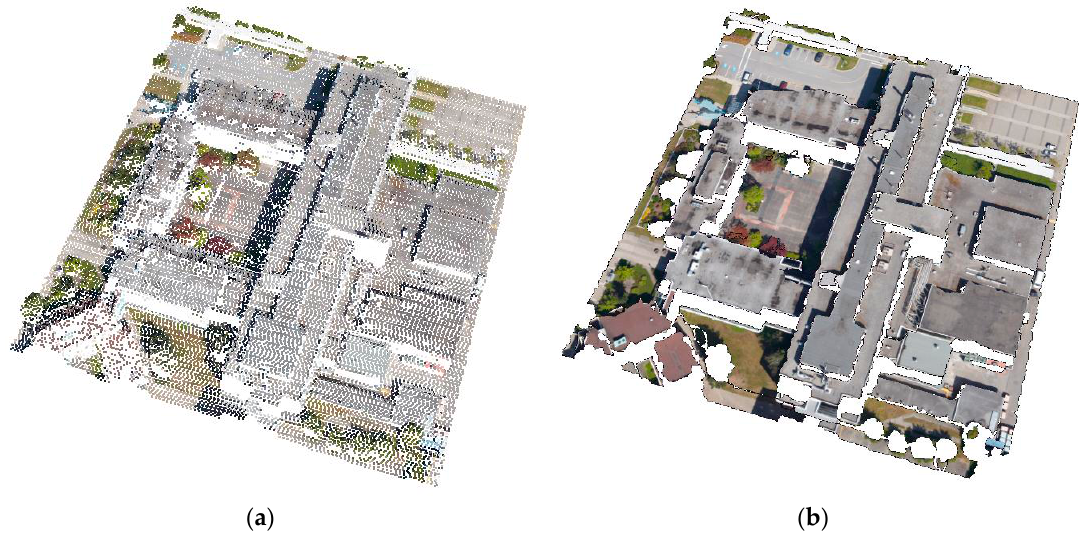
Figure 36. Realistic 3D scene reconstruction results for the provided dataset using ( a ) a traditional point-based and ( b ) the proposed surface-based scene reconstruction techniques. Table 5. Required processing time for 3D scene reconstruction for the provided dataset using point-based, surface-based, and image-based techniques.